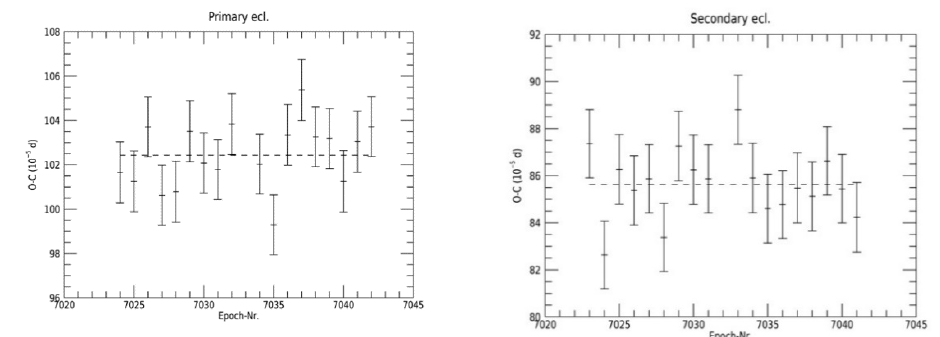
Figure 5. Observed minus calculated (O-C) eclipse minimum times for CM Dra primary and secondary eclipses in TESS sector 26 data. The observed times correspond to Table 1 and the calculated times and epoch numbers are from the ephemeris of [9]. The dashed line is the average O-C value of these eclipses. The size of the error bars is in near perfect agreement with a Gaussian distribution of the minimum times around the dashed line, where the distribution’s width corresponds to the size of the error bars. Table 1. CM Dra eclipse minimum times from the KvW method with five folds, with timing errors from the revised error estimate ( σ T 0 ) and from KvW’s original formula ( σ T 0KvW ), from TESS Sector 26 observations. Epoch numbers are relative to BJD 49,830.757712 for primary eclipses and BJD 2,549,831.390742 for secondary eclipses.